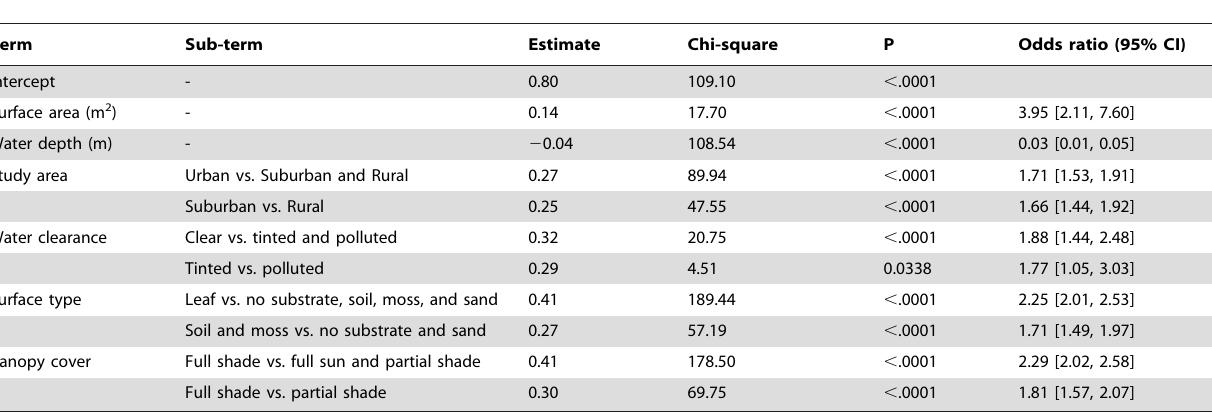
Table 3. Factors that were significantly associated with the presence of immature Aedes albopictus